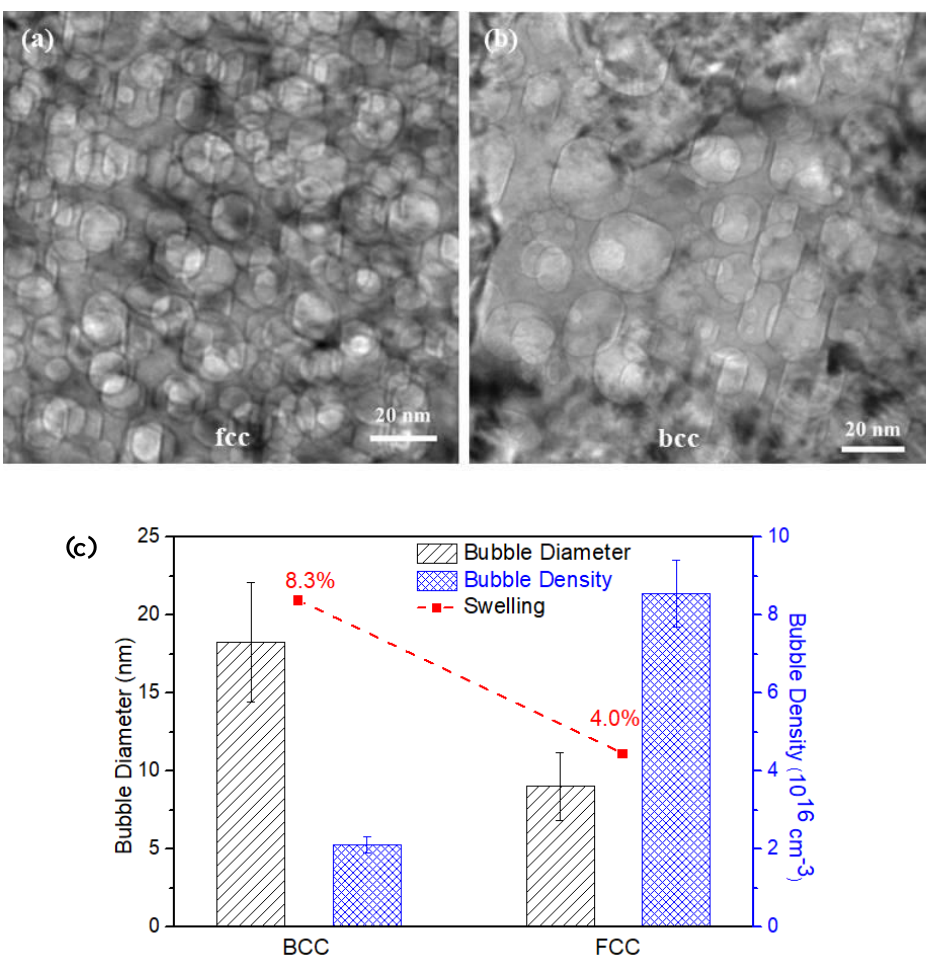
Figure 10. Surface dilation and helium bubbles corresponding to the fcc and bcc phases, ( a ) and ( b ), respectively. ( c ) Statistical data for the helium bubbles formed in the bcc and fcc phases—including the bubble size, bubble density, and bubble swelling.